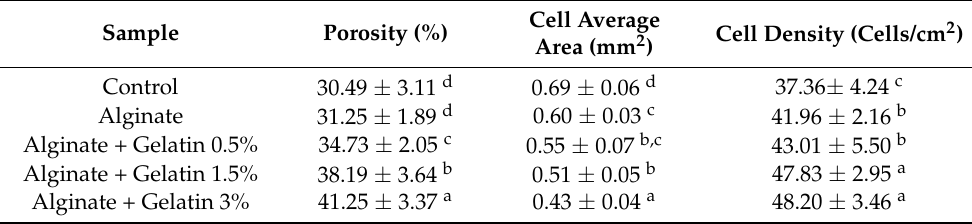
Figure 3. The morphological profiles of cell structure from bread supplemented with encapsulated L. acidophilus in different matrices. Table 3. Morphological characterizations of crumb structures of bread supplemented with encap- sulated L. acidophilus in different matrices.